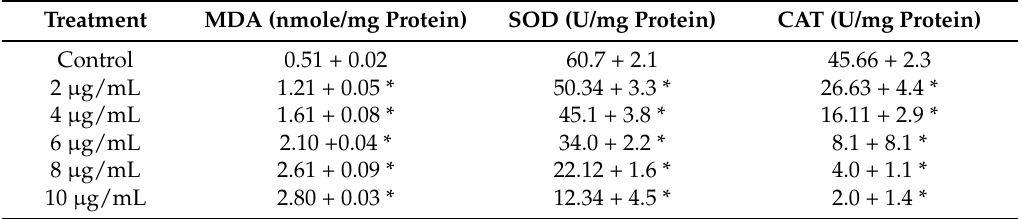
Table 1. Effect of palladium nanoparticles (PdNPs) on malondialdehyde (MDA), superoxide dismutase (SOD), and catalase (CAT) activities. A2780 cells were treated with various concentrations of PdNPs for 24 h. Then cells were harvested and washed twice with an ice-cold PBS solution. Cells were collected, homogenized, and homogenate was centrifuged at 4 ˝ C at 10,000 rpm for 15 min. Concentration of MDA and activities of SOD and CAT were measured. Treatment MDA (nmole/mg Protein) SOD (U/mg Protein) CAT (U/mg Protein)